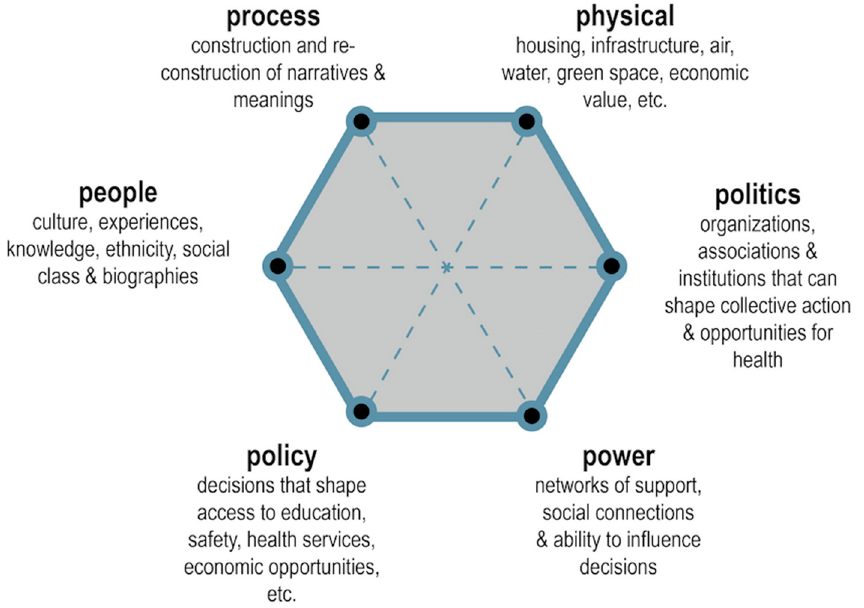
Figure 1. The Relational Framework of Urban Place and Heath Equity.